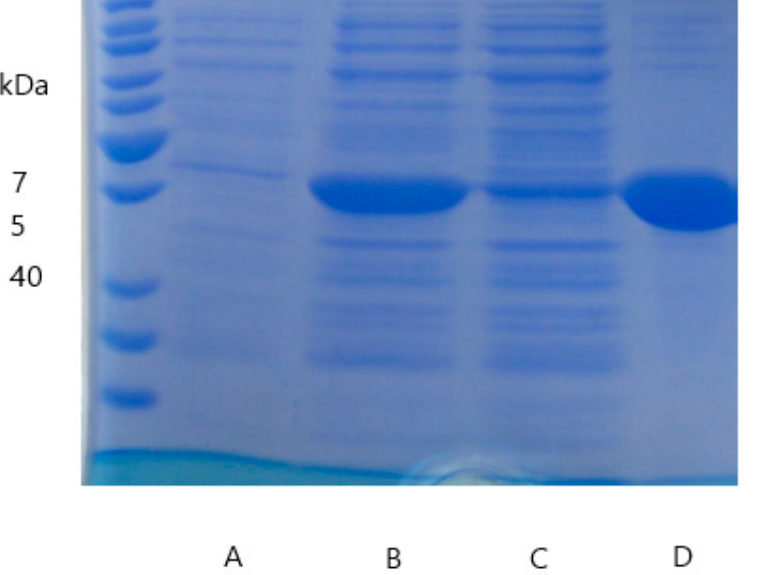
Figure A3. Results of SDS-PAGE illustrating the ( A ) negative control, ( B ) crude extract, ( C ) flowthrough, ( D ) elution during the purification of DypB. Table A5. Specific activity of DypA and DypB at different H 2 O 2 concentrations.